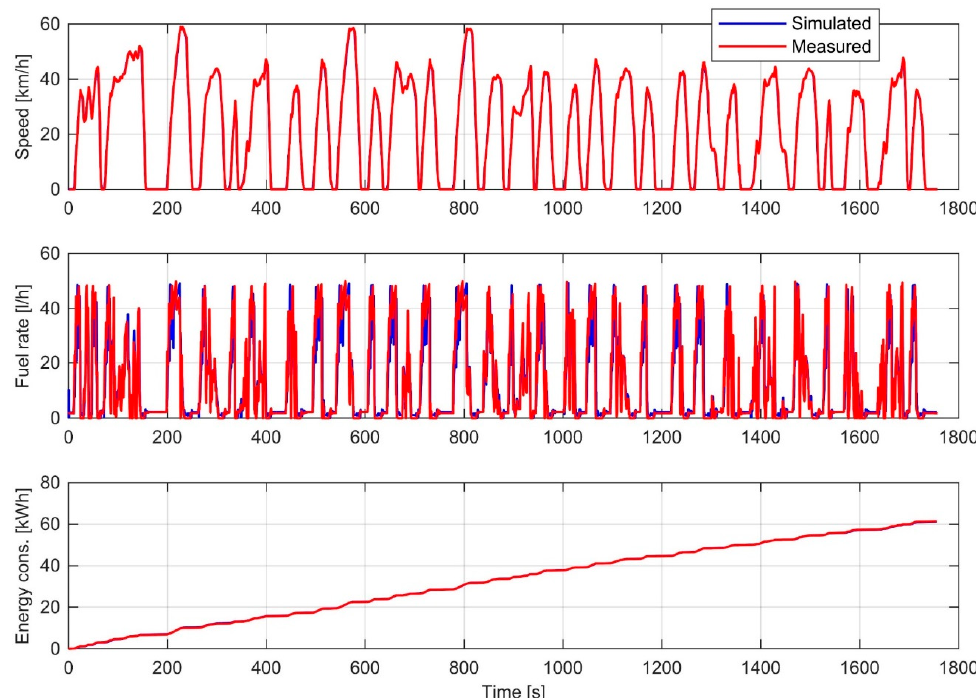
Figure 7. Speed, fuel rate, and cumulative energy consumption during the simulated and actual validation cycle.